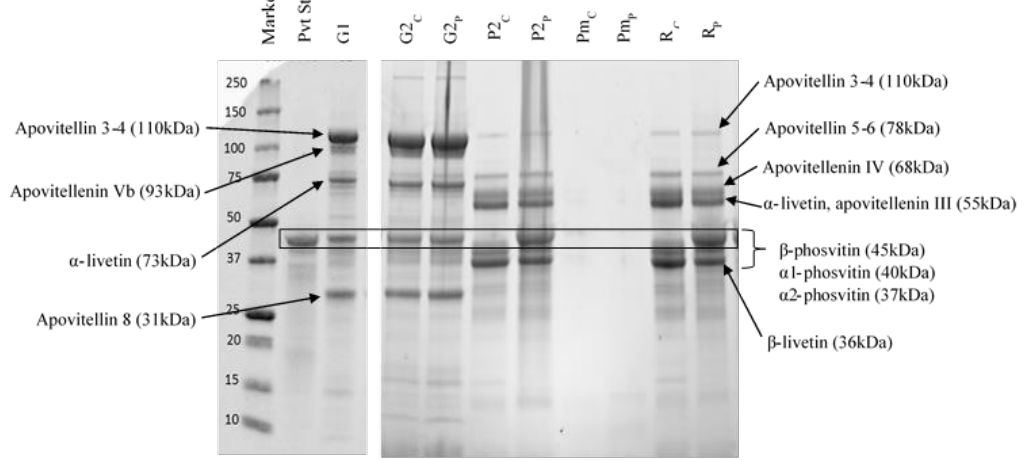
Figure 3. Protein profiles of control and pressure-treated fractions of egg yolk obtained by sodium dodecyl sulfate polyacrylamide gel electrophoresis (SDS-PAGE). Pvt Std: commercially phosvitin standard, G1: initial granule, G2 C : control granule, P2 C : control plasma, G2 P : pressure-treated granule,